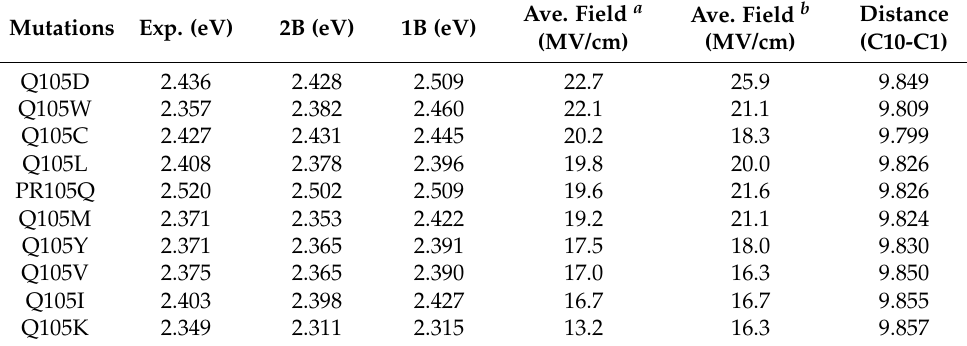
Table 3. With the Amber and PPC charge models, the calculated average electric field (in MV/cm) between C10 and C1 (see Figure 2) along the polyene chain of chromophore based on the ensemble average over 100 snapshots from QM/MM MD simulation. Experimental values (eV) of excitation energies are given for comparison. 2B represents the two-body corrected QM excitation energy, and 1B represents the one-body QM excitation energy calculated by EE-GMFCC. Mutations Exp. (eV) 2B (eV)